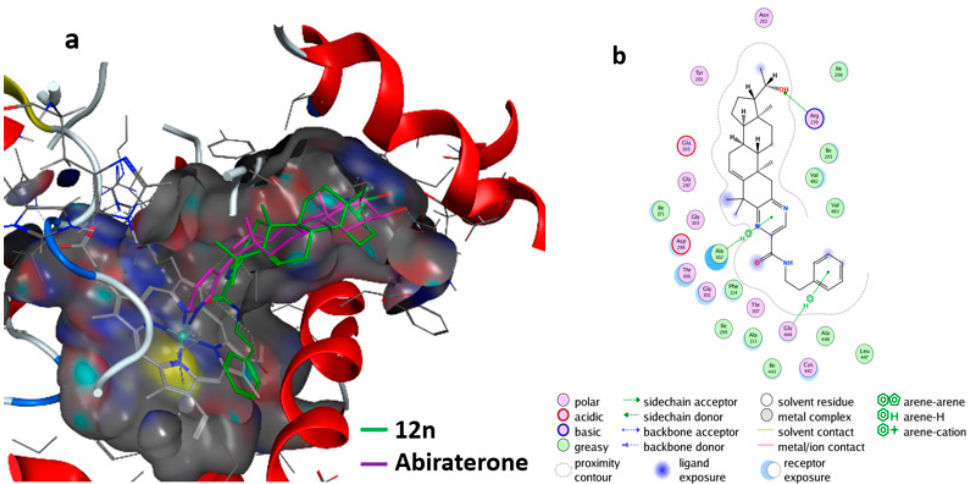
Figure 6. Interaction of the compound 12n with the CYP17A1 (6CIZ) receptor: ( a ) docking of compound 12n (green) with 6CIZ and Abiraterone (purple) was used as the reference; ( b ) interaction of compound 12n with